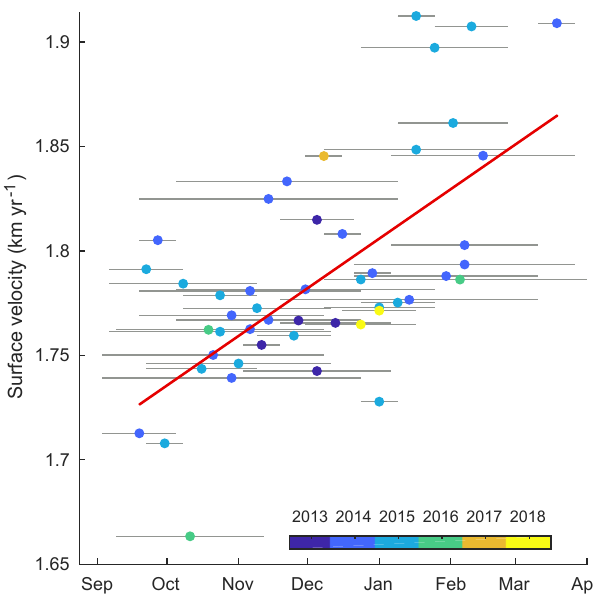
Figure 2. Ice front acceleration from GoLIVE (Landsat 8). The Go- LIVE data set contains many overlapping TIS velocity measure- ments captured between September and April of each year. The ve- locities here represent all displacements measured over 16 ≤ d t ≤ 112 days (indicated by gray lines), averaged within the green poly- gon in Fig. 1. The red trend line is a linear least-squares fit to the observations, indicating a typical spring-to-autumn acceleration of 0.8myr − 1 per